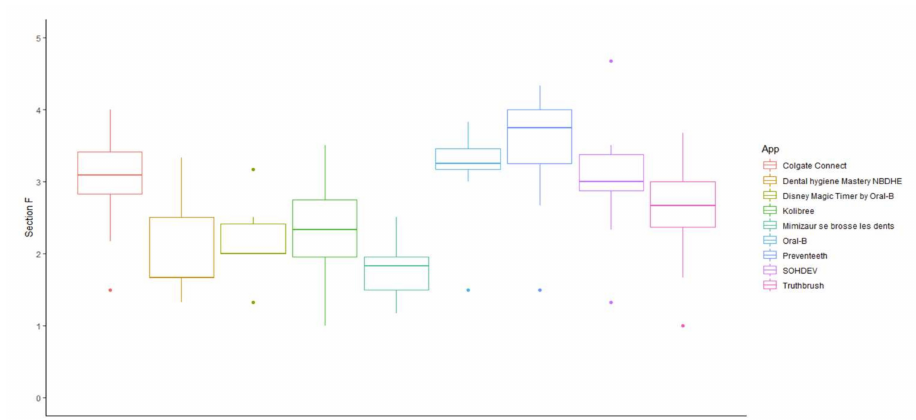
Figure 4. App-specific scores of oral-health-related mobile apps (section